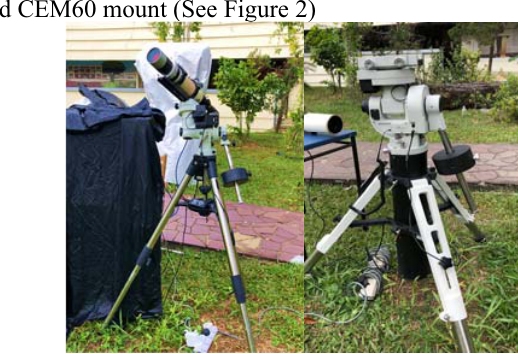
Figure 2 . Borg 76 mm refractor mounted on CEM25P mount (left) and CEM60 mount (right) (cid:2) Borg 76 mm achromat refractor (See Figure 2 left) (cid:2) Megrez-90 refractor (See Figure 3)